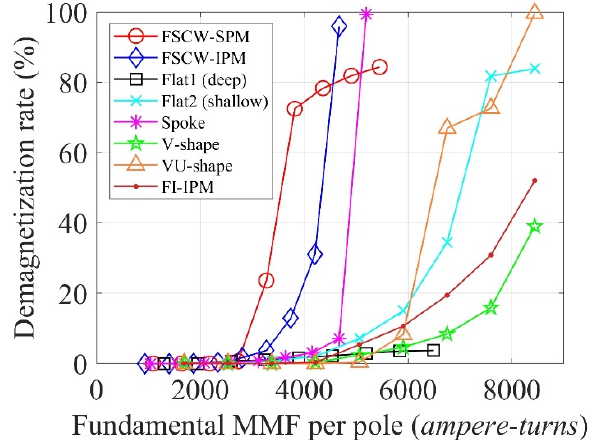
Figure 4. Demagnetization rate vs. fundamental MMF per pole for the eight baseline PM ma- chines.